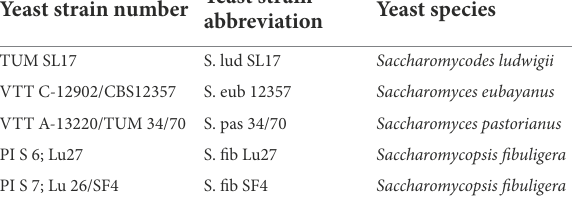
TABLE 1 Yeast species and strain numbers with corresponding abbreviations used in this study. Yeast strain Yeast strain number Yeast abbreviation